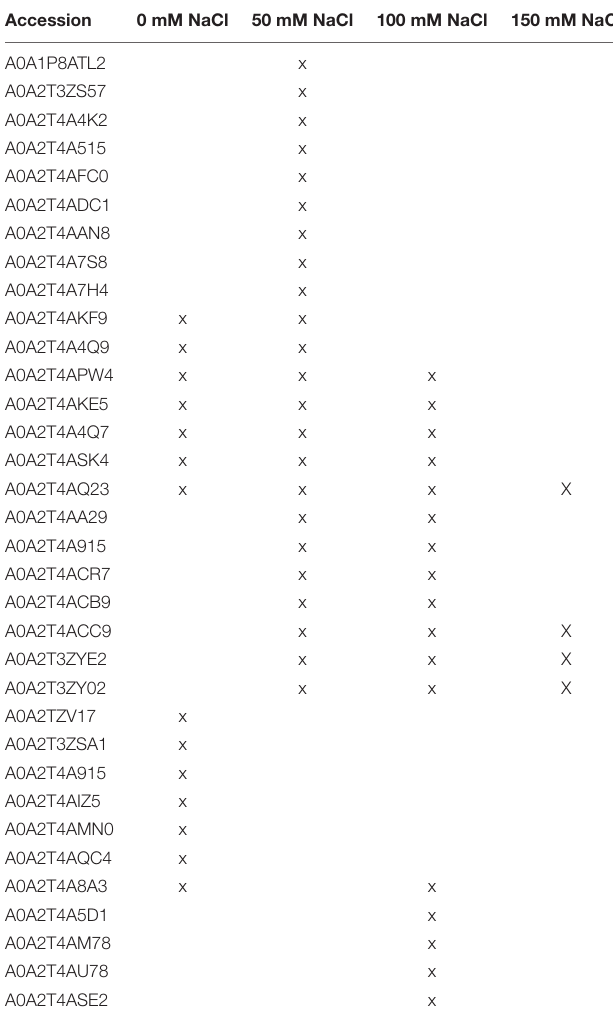
TABLE 3 | Fungal proteins secreted under specific salt conditions in the